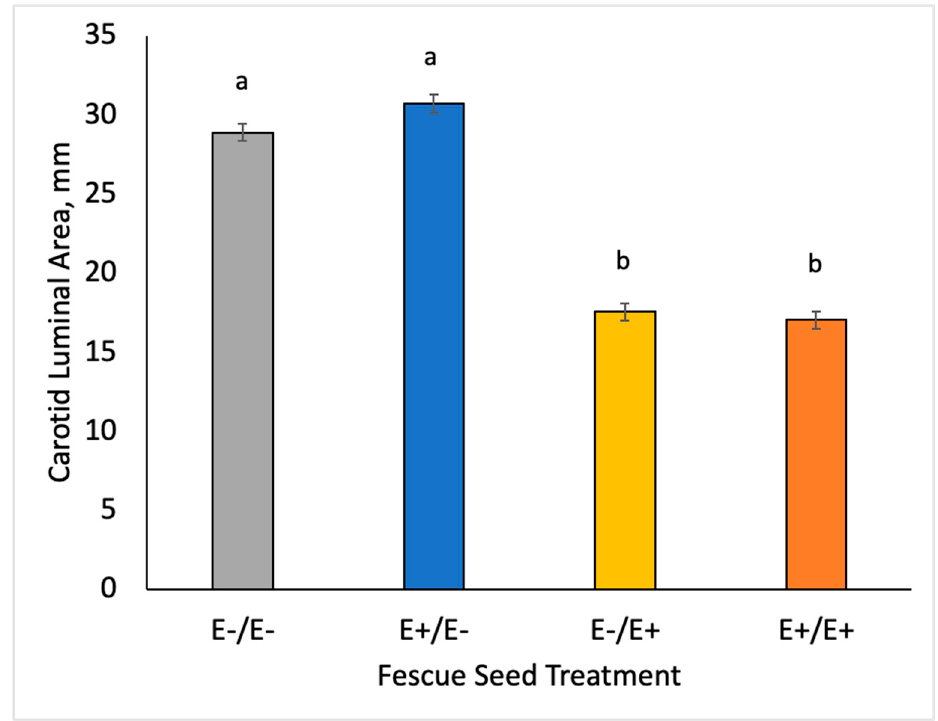
Figure 2. Carotid luminal area was measured on d 123 ± 7 in ewes fed E − or E+ fescue seed from d 35 to 85 and/or d 85 to parturition. a,b Superscripts denote differences ( p < 0.05).